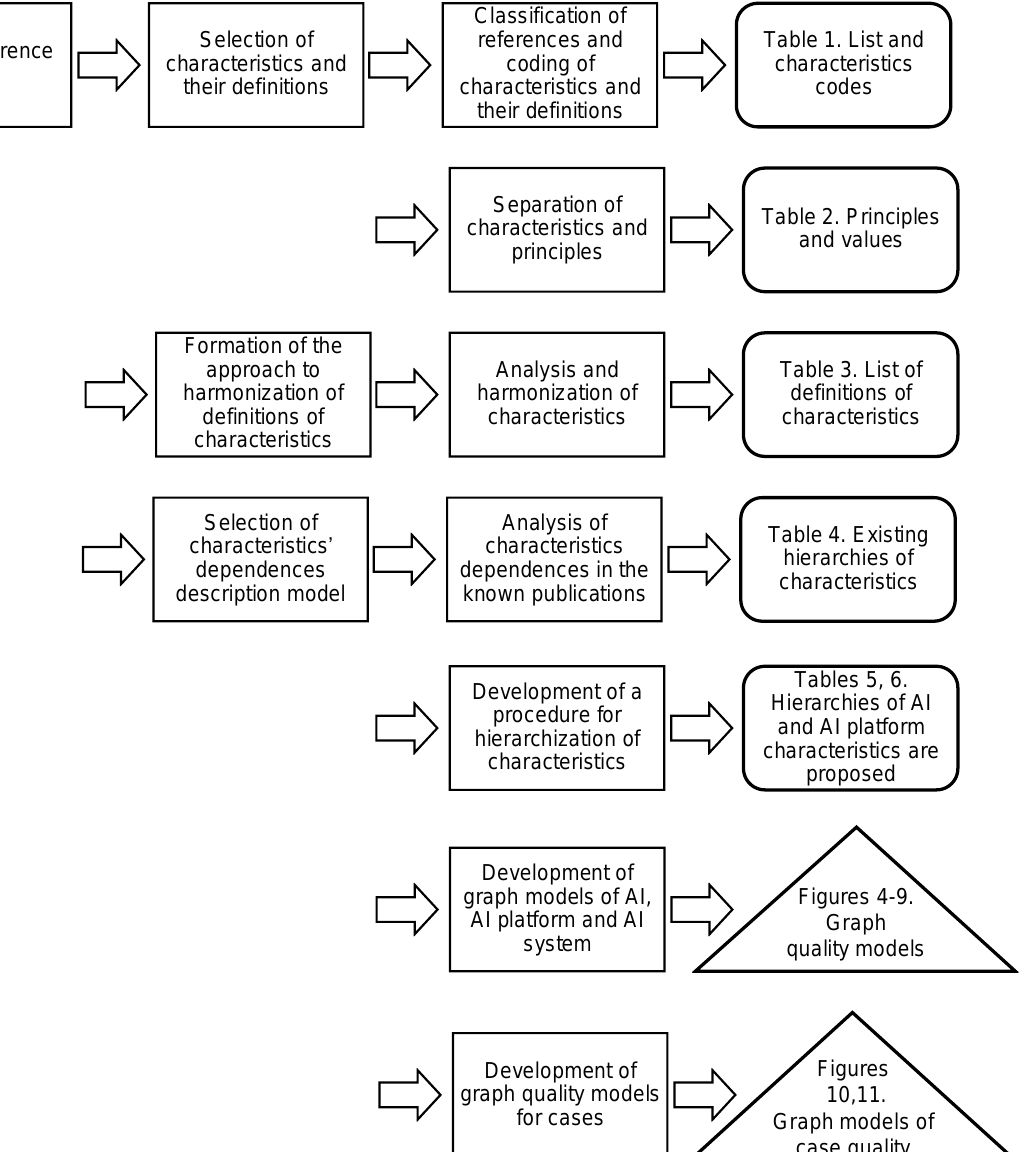
Figure 2. The sequence of AI quality models